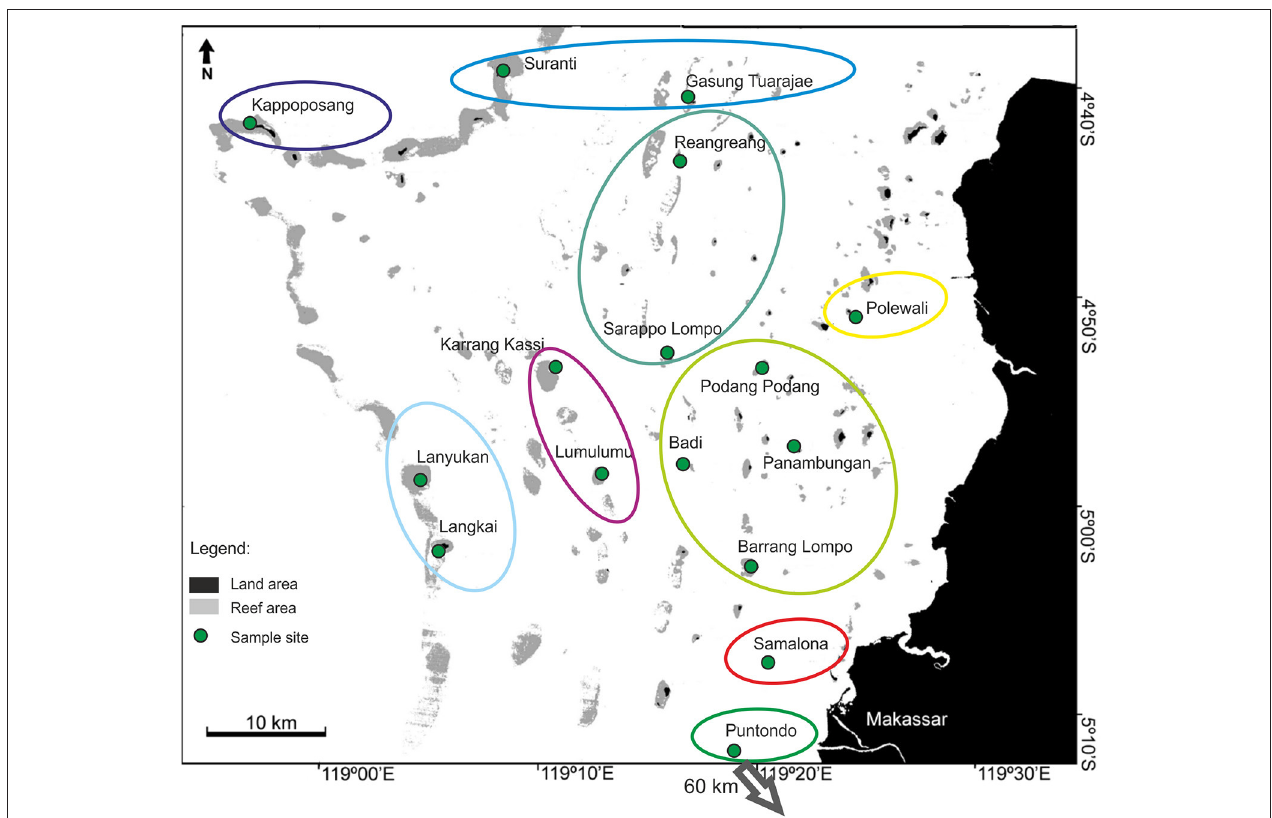
FIGURE 5 | Results of the hierarchical AMOVA (Arlequin ver.3.5, Excoffier et al., 2005) for the sea squirt, Polycarpa aurata , in Spermonde Archipelago and Puntondo, Indonesia. Colored circles represent the highest significant F ct -value (0.024; p = 0.001), dividing the dataset into 9 groups.